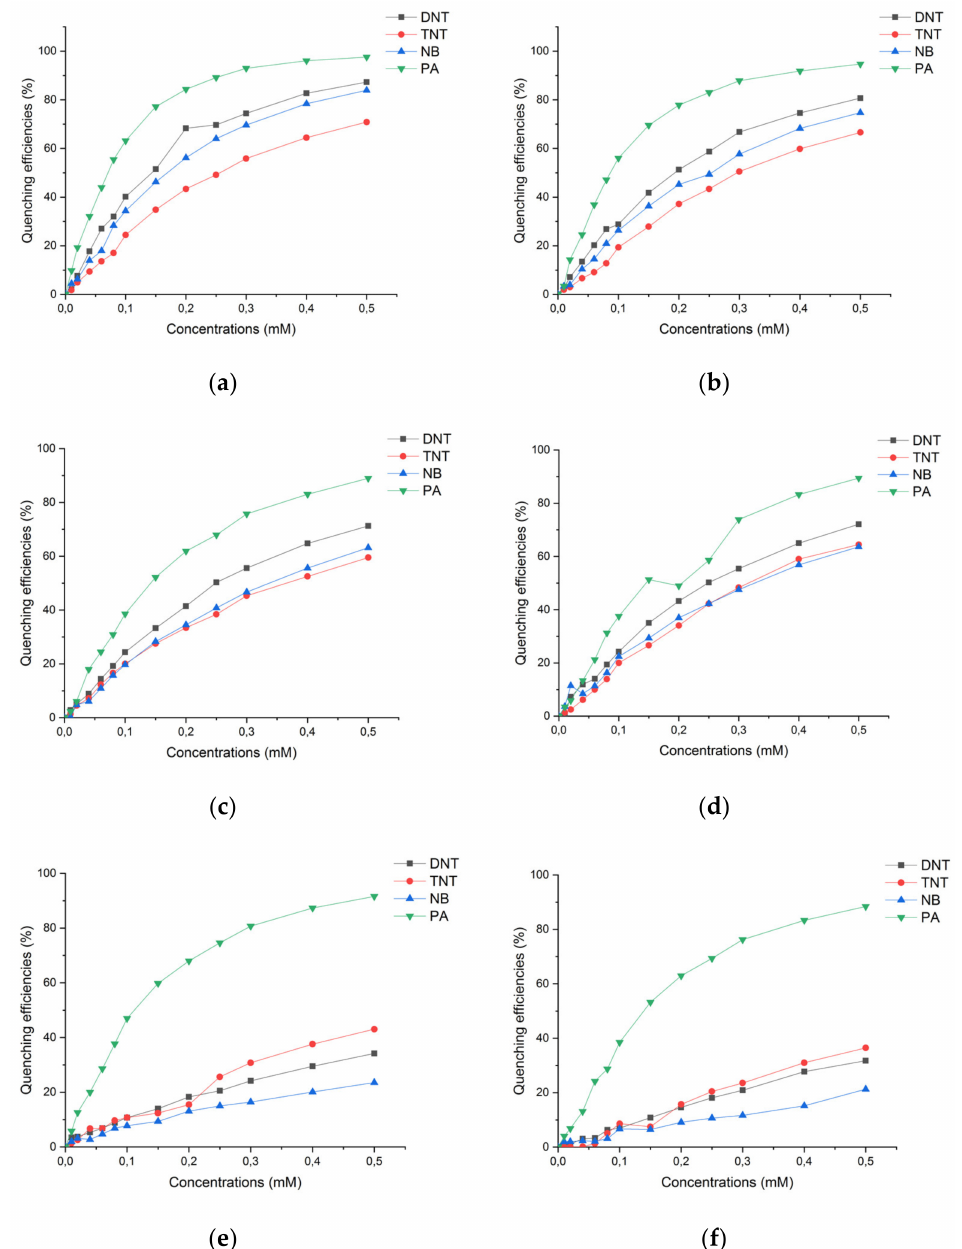
Figure 6. Quenching efficiencies of NB, DNT, TNT, and PA relative to fluorophores P1 ( a ), P2 ( b ), P3 ( c ), P3* ( d ), P4 ( e ), and P5 ( f ) at mM